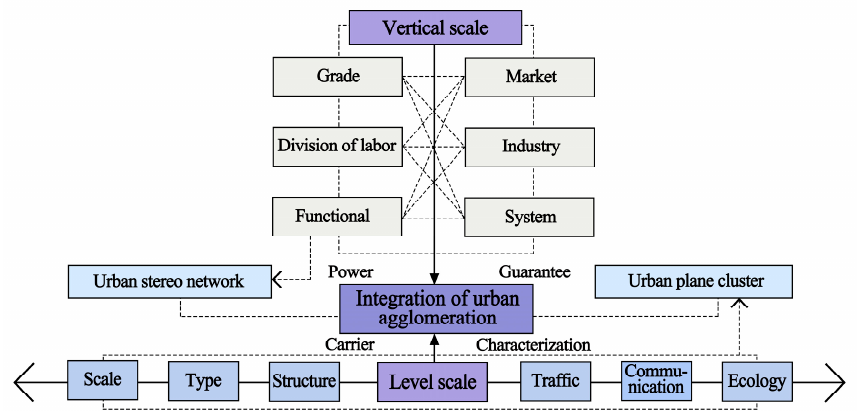
Figure 2. H-V model for urban agglomeration integration.